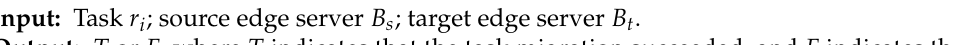
Algorithm 1 Path Selection